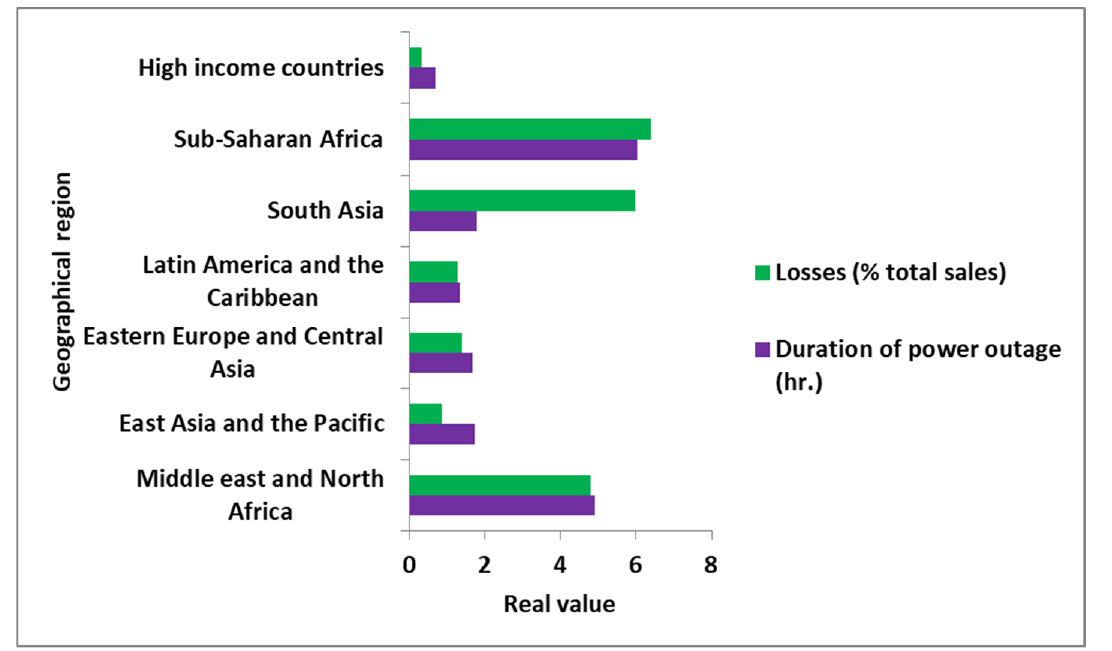
Figure 2. Global losses and power outage durations (The World Bank’s Enterprise Surveys (WBES) database 2005–2016) [9].